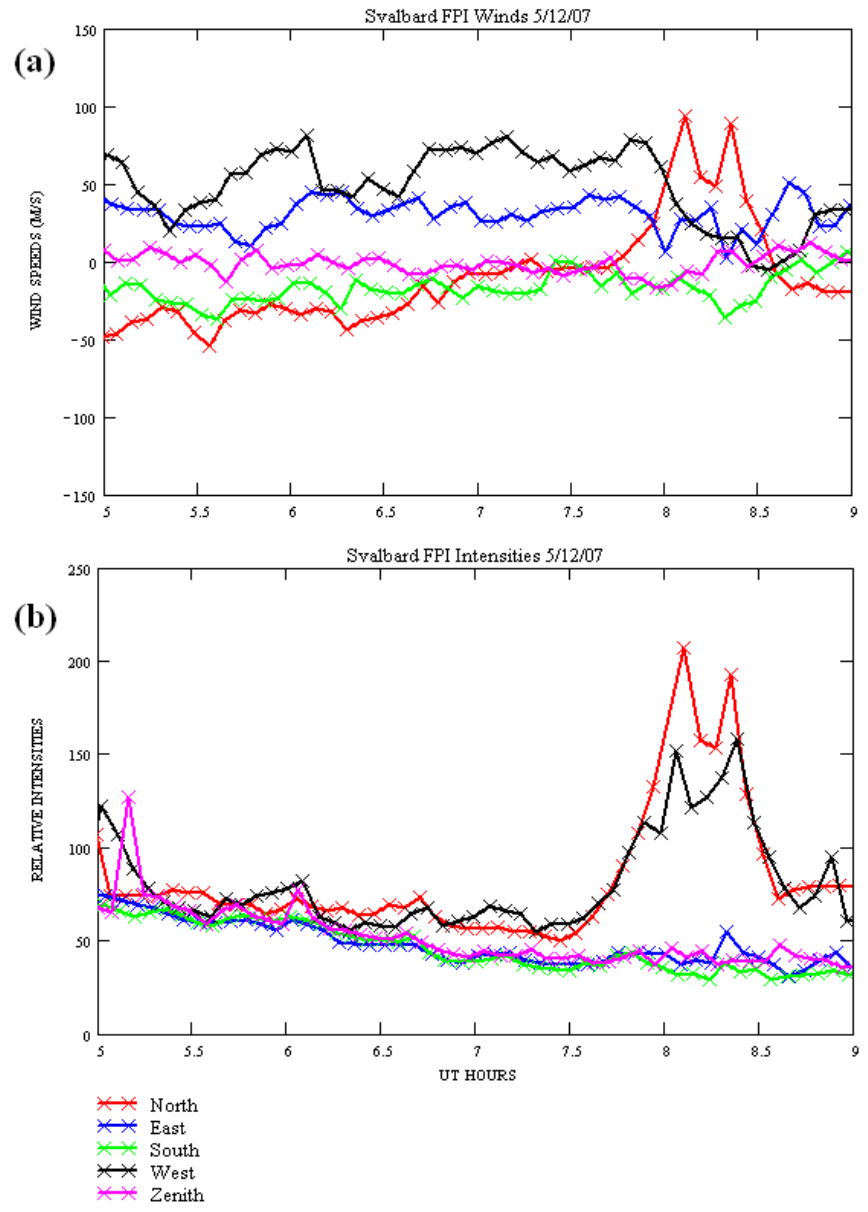
Fig. 4. Svalbard FPI results for 5 December 2007 from 05:00 to 09:00UT showing (a) wind velocities, positive northward and eastward, containing a sudden surge in meridional wind component only to the north and not to the south around 08:00 to 08:30UT; (b) FPI intensities with peaks to the north and west at the time of the surge in the meridional wind.